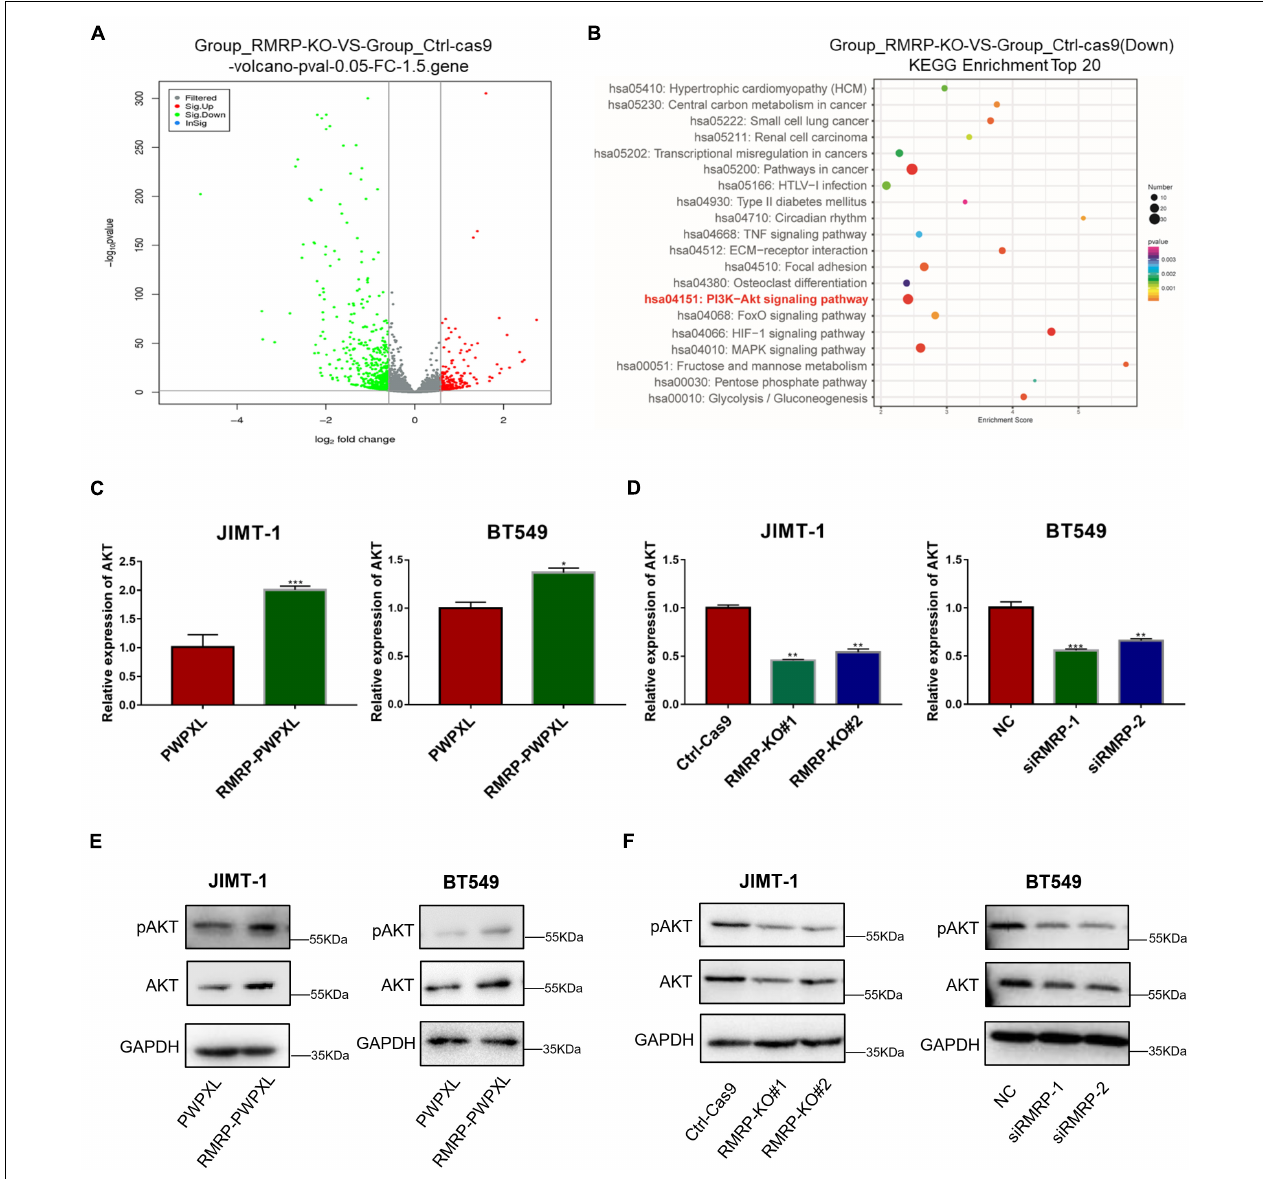
FIGURE 3 | RMRP upregulates AKT expression. (A) Differentially expressed gene profile in response to RMRP knockout revealed by the volcano-map. (B) Downregulated cancer-related pathways in response to RMRP knockout revealed by KEGG enrichment. (C) Overexpression of RMRP elevates AKT mRNA expression in JIMT-1 and BT549 cells. (D) Depletion of RMRP reduces AKT mRNA expression in JIMT-1 and BT549 cells. (E) Overexpression of RMRP elevates AKT protein expression and phosphorylated AKT in JIMT-1 and BT549 cells. (F) Depletion of RMRP reduces AKT protein expression and phosphorylated AKT in JIMT-1 and BT549 cells. * p < 0.05, ** p < 0.01, *** p <